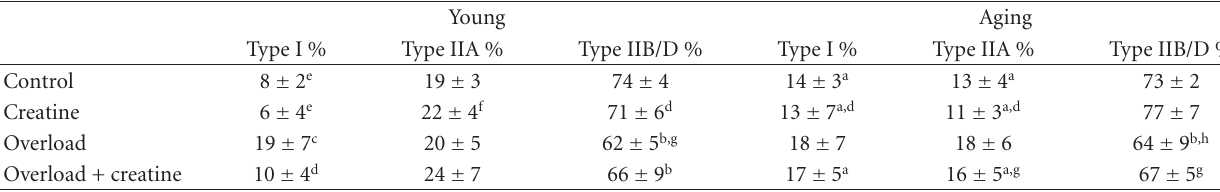
Table 4: Percent fiber type of plantaris muscle for young and aging animals.